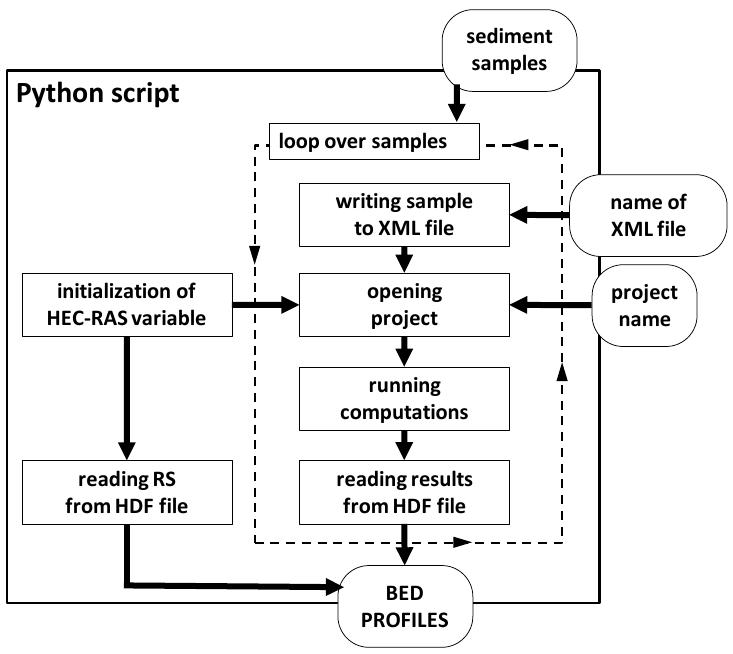
Figure 6. Main computational elements of Example 3. Figure 7. Main computational elements of Example